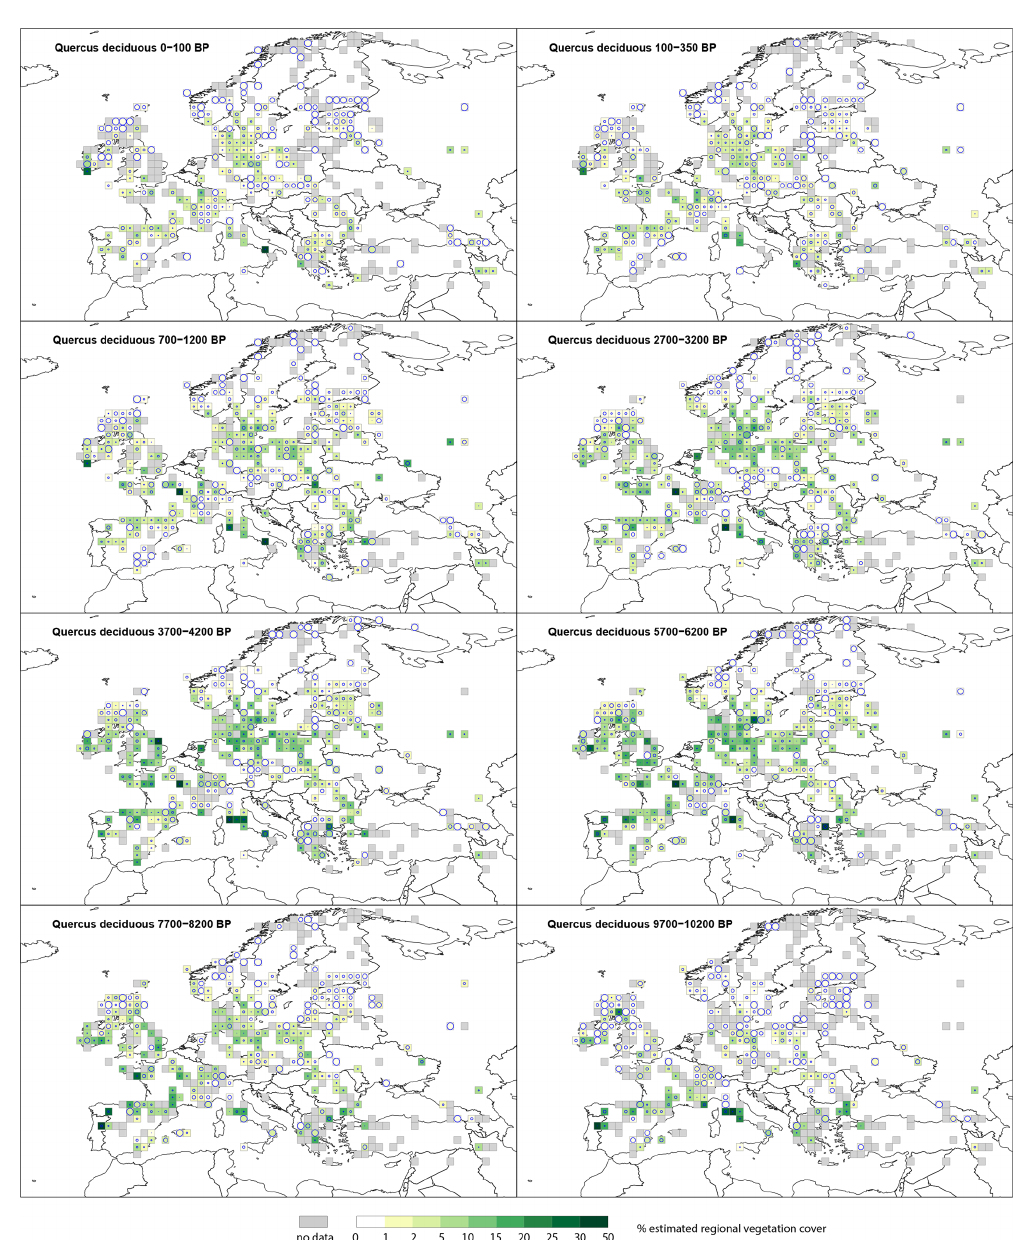
Figure D2. Grid-based REVEALS estimates of deciduous Quercus cover in eight Holocene time windows. Percentage cover in 1% intervals between 0% and 2%, 3% intervals between 2% and 5%, 5% intervals between 5% and 30%, and 20% intervals between 30% and 50%. Intervals represented by increasingly darker shades of green from 2%–5%. Grey grid cells have no data (pollen) for Calluna vulgaris in the mapped time window. The circles represent the coefficient of variation (CV; the standard error divided by the REVEALS estimate). When SE ≥ REVEALS estimate, the circle fills the entire grid cell, and the REVEALS estimate is not different from zero. This occurs mainly where REVEALS estimates are